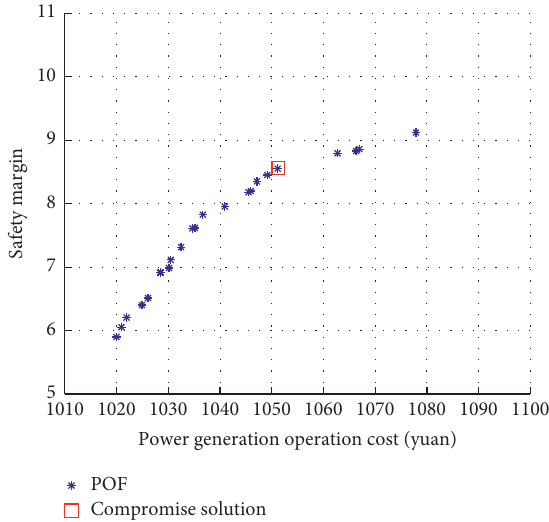
Figure 4: POF from initial failure L